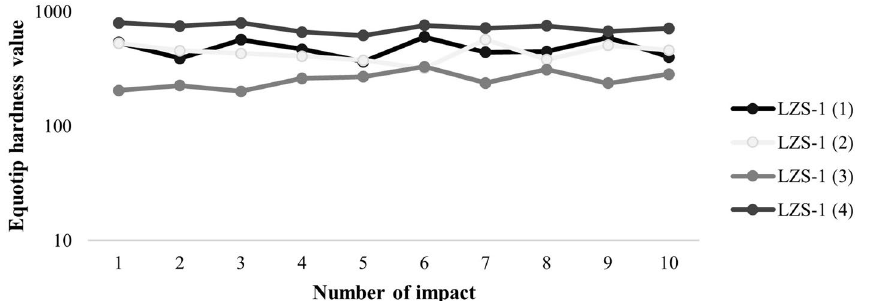
Figure 10. Hardness data from Equotip 3